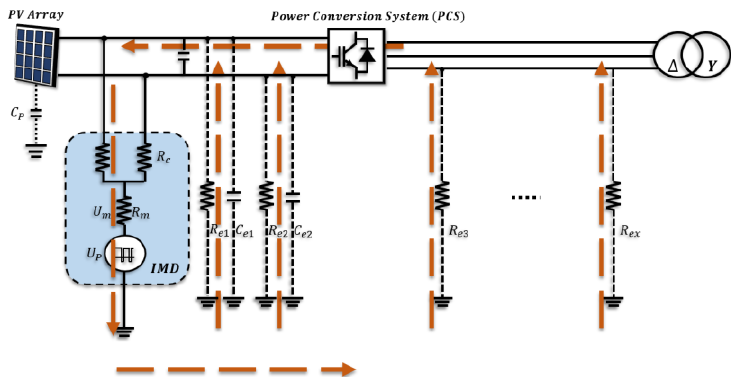
Figure 5. Leakage current loop in ungrounded system connected to transformerless solar photovoltaic (PV) generation facility with IMD.